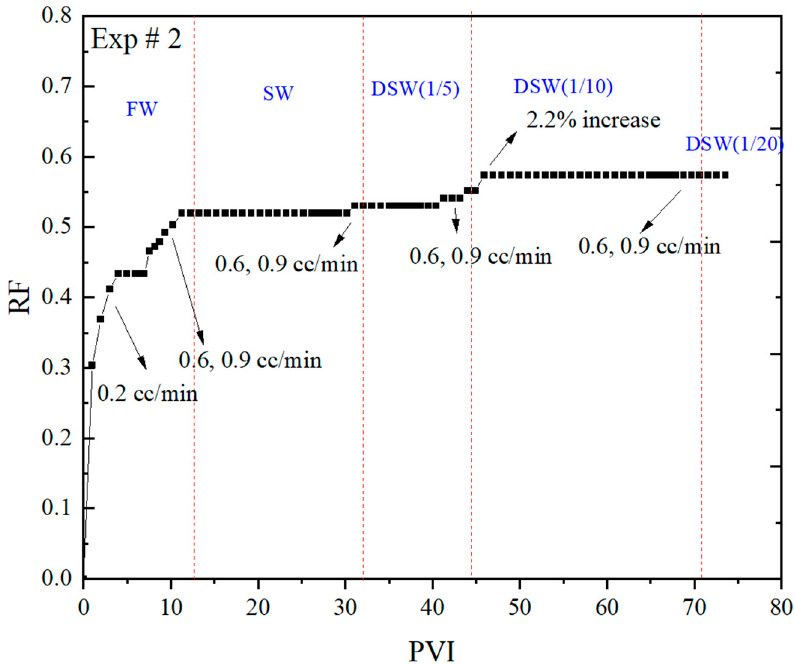
Figure 5. Oil recovery of experiment 2 adding stearic acid to hexadecane as the oil phase and Stevns Klint as the rock material. The flow rate starts with 0.2 mL/min and increased to 0.6 and then to 0.9 mL/min before changing each brine.